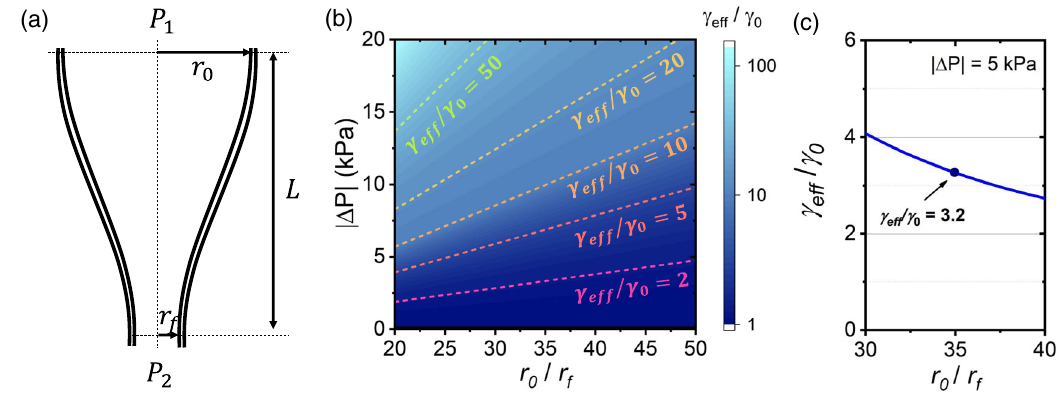
Fig. 2 | Toymodel for the shearrateonthe fi bercore surfaces. a Diagram of the transition region between the preform and the fi ber. P 1 and P 2 stand for the pressureinthepreformandinthe fi ber,respectively; r 0 and r f arethepreformand